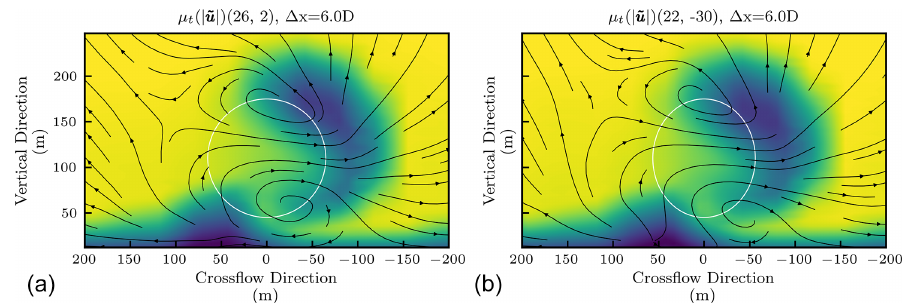
Figure 7. Time-averaged flow fields associated with the optimal power (left) and loading (right) found by the optimization, viewed from upstream, six rotor diameters away from the front turbine and one rotor diameter upstream of the downstream turbine. Brighter colors indicate faster velocity magnitudes. In each plot, the vertical location and cross-flow location of the back turbine are shown as a white